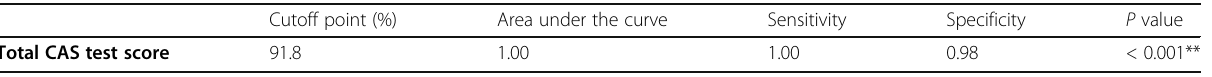
Table 7 Cutoff points by percentage for differentiation between group I and group III Cutoff point (%)